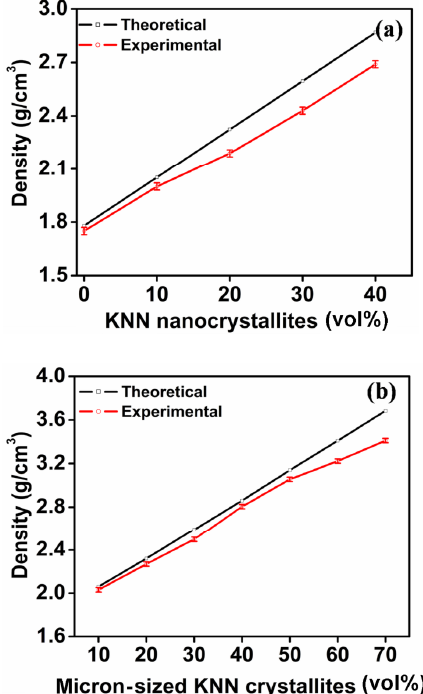
Fig. 3 Graphical representation of the variation of the density as a function of volume fraction for (a) nano- and (b) micron-sized KNN crystallites added to